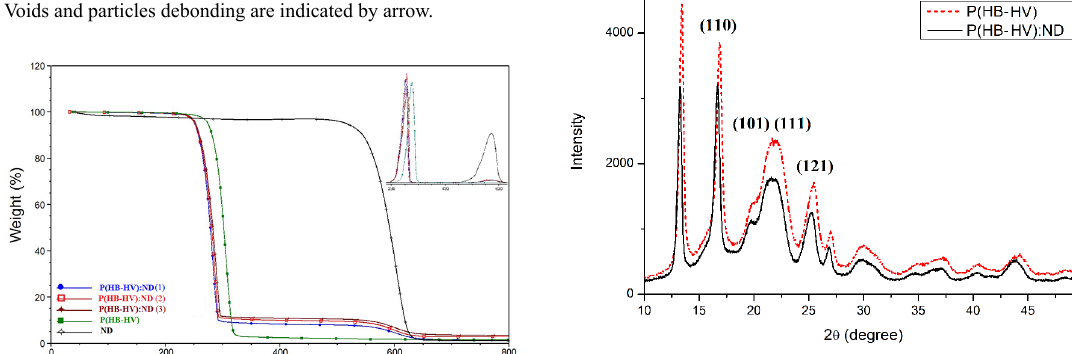
Figure 4. XRD spectra of P(HB-HV) and P(HB-HV):ND